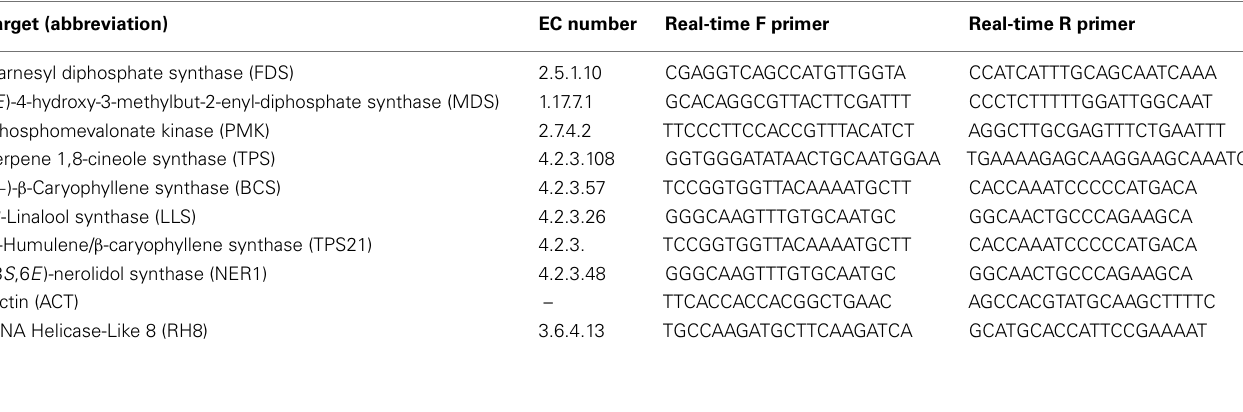
Table 1 |Targets used for real-time qPCR, enzyme commission (EC) numbers and primer